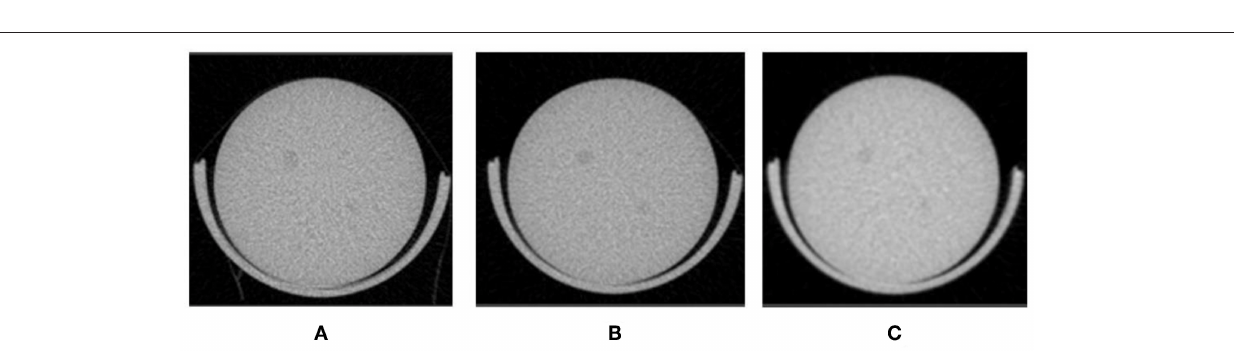
FIGURE 10 | Contrast phantom to evaluate contrast at low-doses (A) Scan time: 140s and dose 12.5 mGy (B) 57s and 9.9 mGy (C) 7s and 5.8